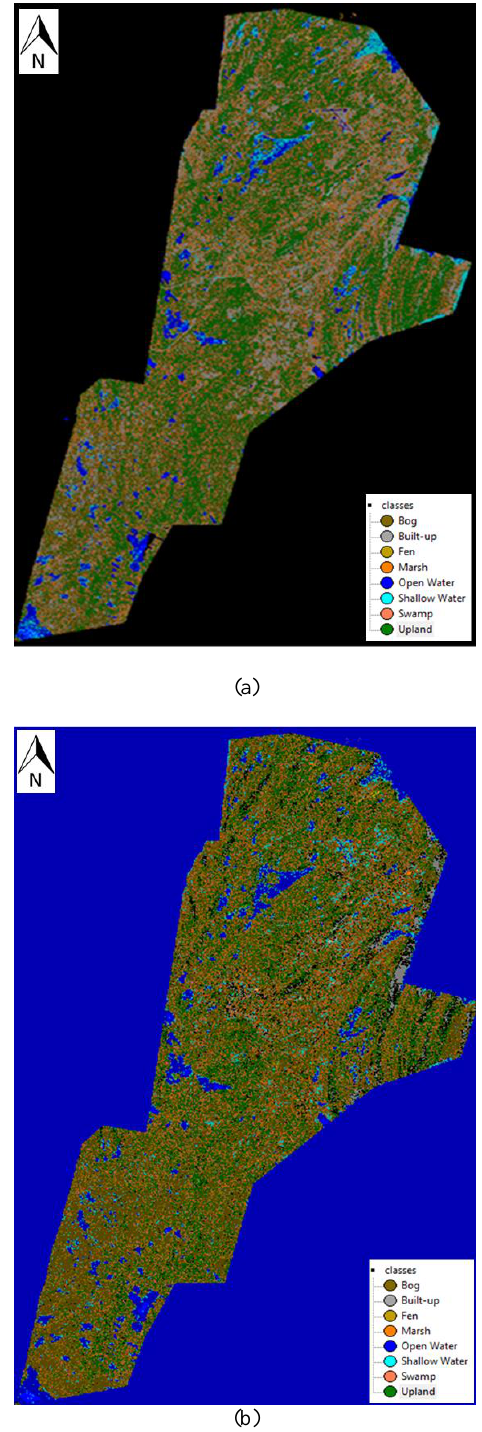
Figure 4. Classification results: (a) Wishart classification method, (b) Fisher-based Wishart classification method.